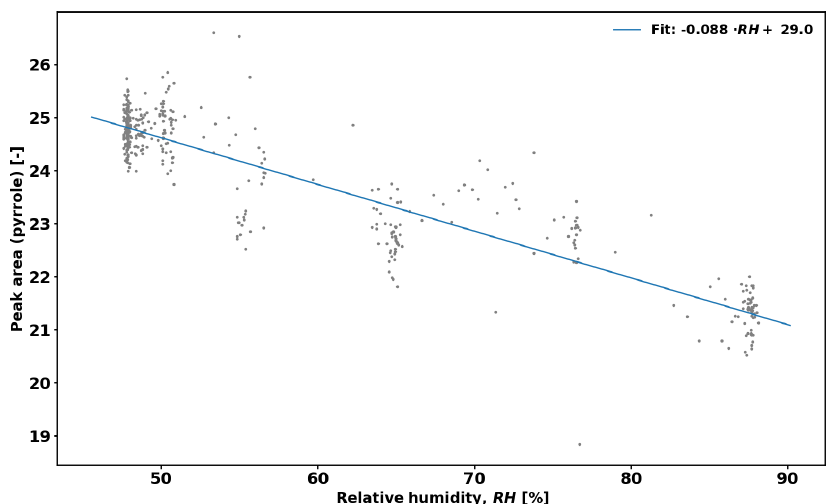
Figure 1. Change in pyrrole level (C 2 ) according to relative humidity (RH) in the CRM